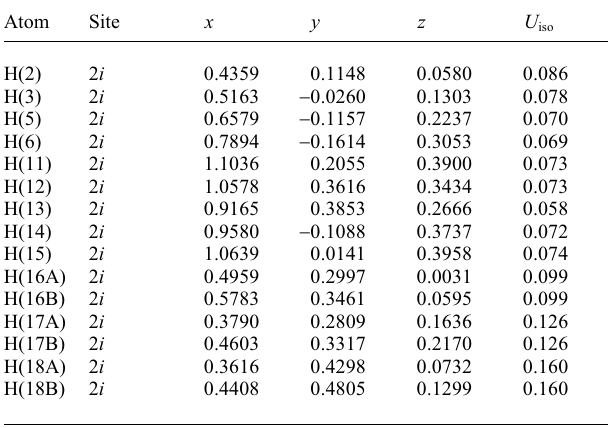
phenanthrolin-2-yl)imidazolylidene ligands with one acetonitrile of crystallization. The high R value of title compound may be caused by disorder of the F atoms in the PF group.The geometry 6 around the iridium is distorted octahedral with two NHC units trans to two phenanthroline nitrogen atoms, similar to reported iridium(III) complex [5]. The two phenanthroline rings are per- pendicular to each other with a bite angle of 86.67°. The com- pound crystallized in the triclinic space group P1, whereas the previously reported analogous Table 2. Atomic coordinates and displacement parameters (in Å 2 )